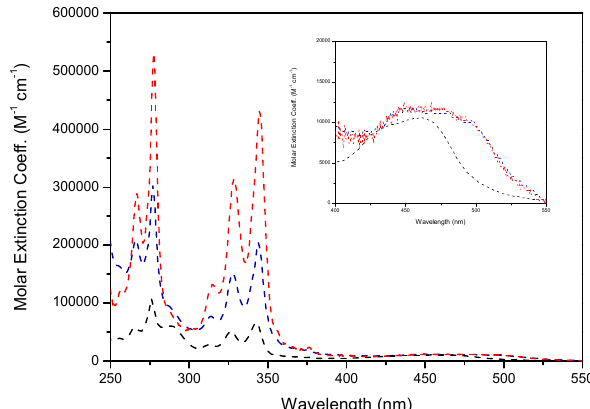
Figure 12. Absorption spectra of Ru(II) trisbipyridine complexes [Ru(Bpy) 2 (Bpy-Py2)] 2+ (black) in acetonitrile and [Ru(Bpy-Py2) 3 ] 2+ (blue) and [Ru(BpyG1-Py4) 3 ] 2+ (red) in THF. “Reprinted from